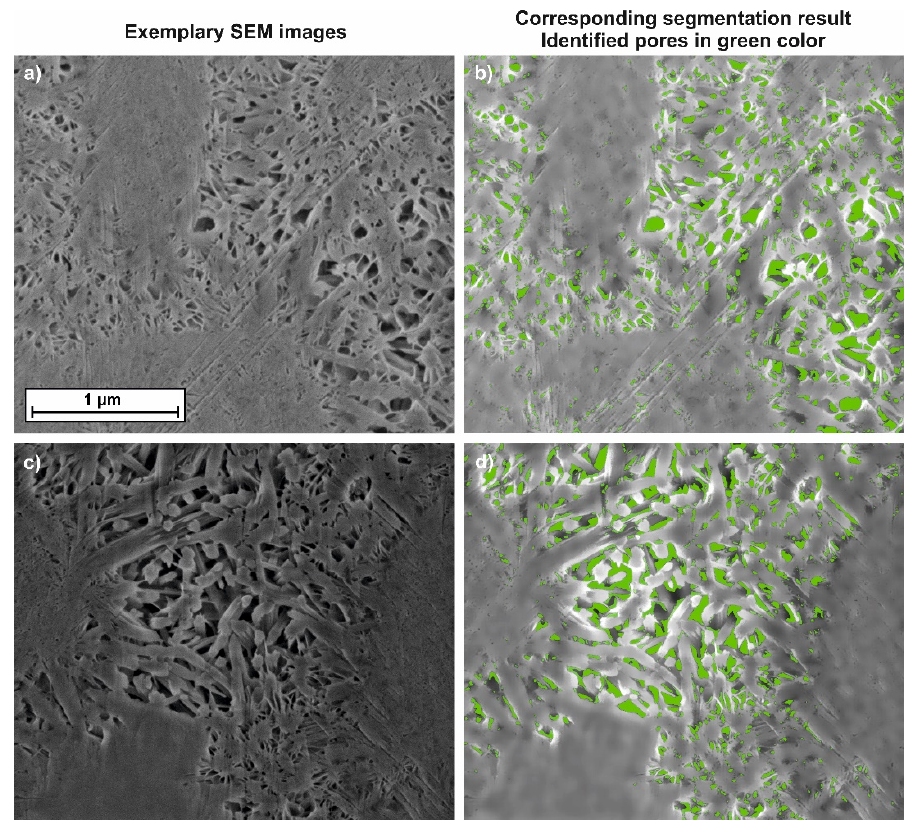
Figure 3. Two exemplary image segmentation results. The acquired SEM images ( a,c ) and the resulting segmentation with the pores in green ( b,d ). All images have the same scale bar.